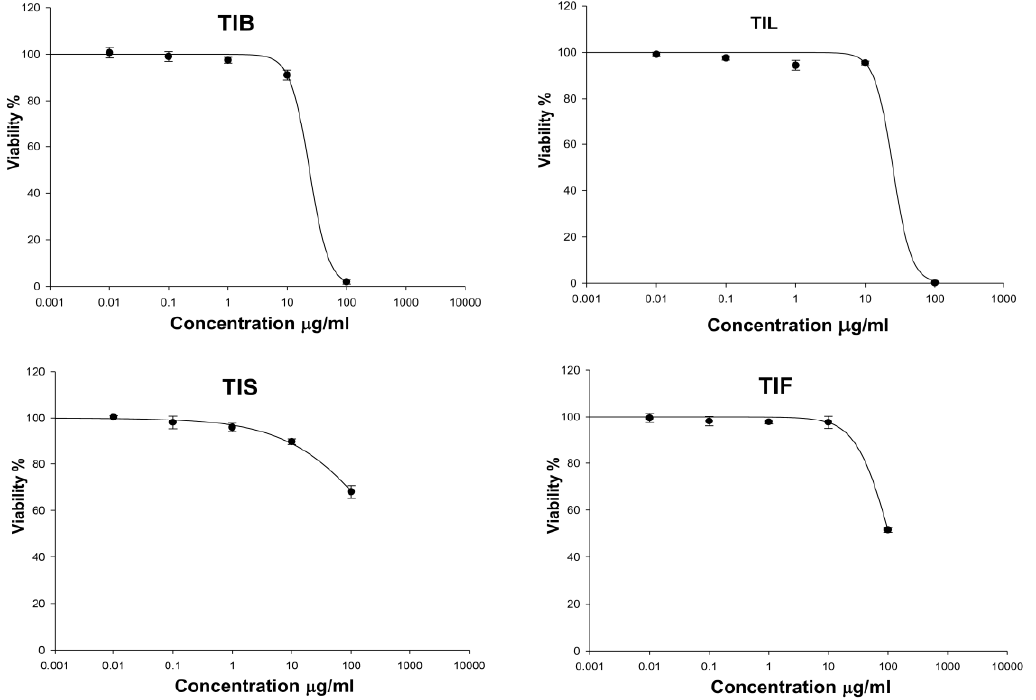
Figure 4. The effect of n -hexane extract from various organs of T. indica : TIB (bark), TIL (leaves), TIS (seeds), and TIF (fruits) on Human Skin Fibroblast cells (HSF) viability.